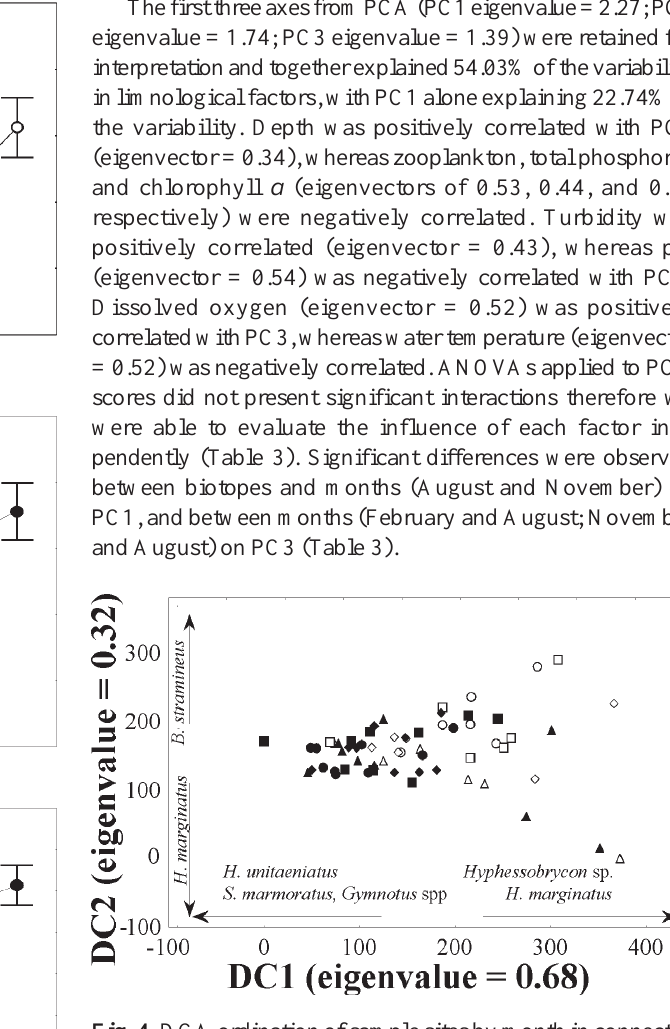
Fig. 4. DCA ordination of sample sites by month in connected [February ( ), May ( ), August ( ), November ( )] and disconnected lagoons [February ( ), May ( ), August ( ), November ( )]. Arrows indicate the direction of influence of species in the